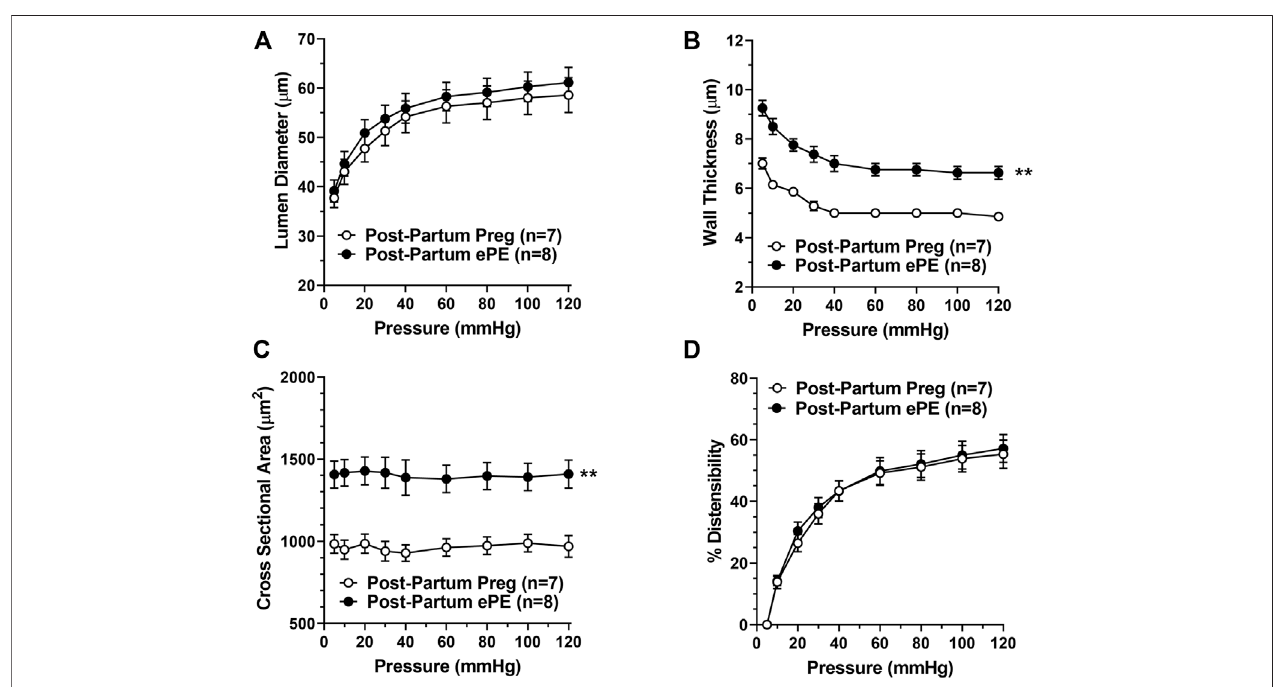
FIGURE 6 | Passive structural and biomechanical properties of hippocampal arterioles (HAs) 5 months after either a healthy pregnancy or experimental preeclampsia (ePE). (A) Lumen diameters of fully relaxed HAs across the intravascular pressure range 5 – 120 mmHg were of similar size between groups. (B) Wall thickness and (C) cross-sectional area were increased in HAs from Post-Partum ePE rats compared to Post-Partum Preg rats at all pressures studied. (D) Distensibility of HAs was similar between groups. Data are mean ± SEM, ** p < 0.01 by Mann-Whitney test.